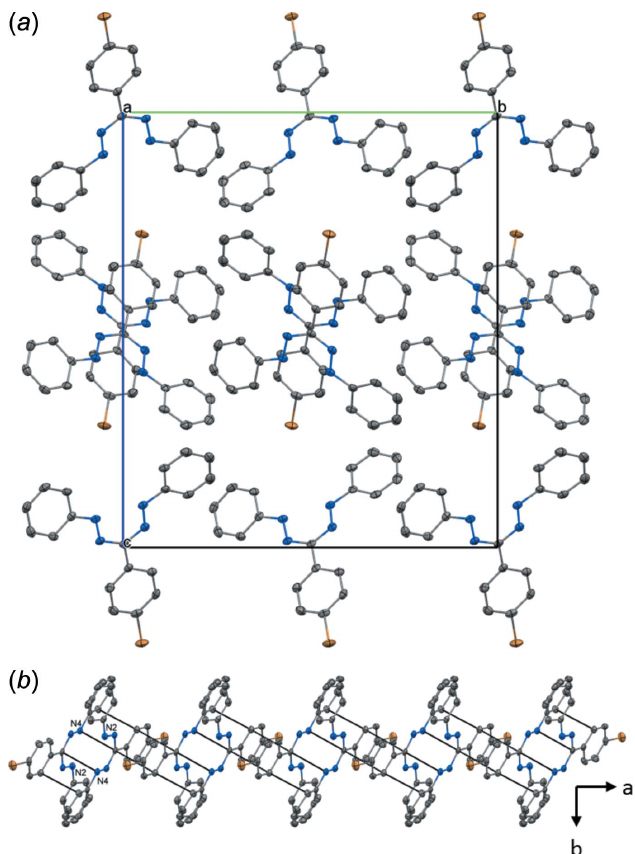
Figure 2 ( a ) Unit cell of 1 viewed parallel to the (100) plane. ( b ) Stacks of dimers formed along the a -axis direction. Two nitrogen atoms of two molecules are labelled.